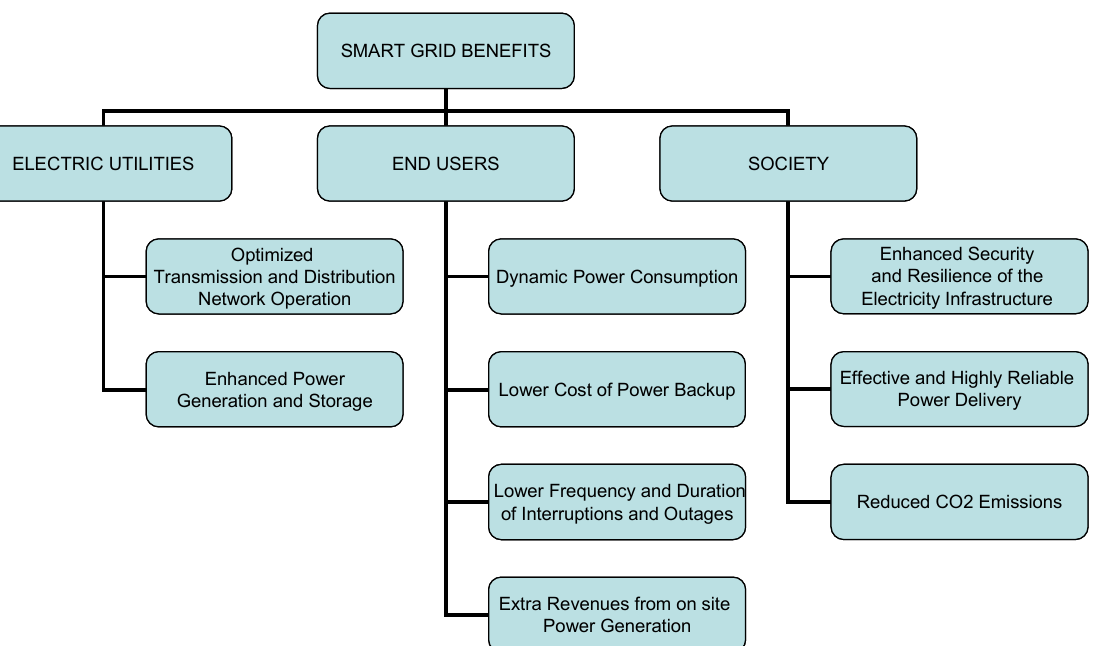
Figure 1. Classification of smart grid benefits with regard to the benefited